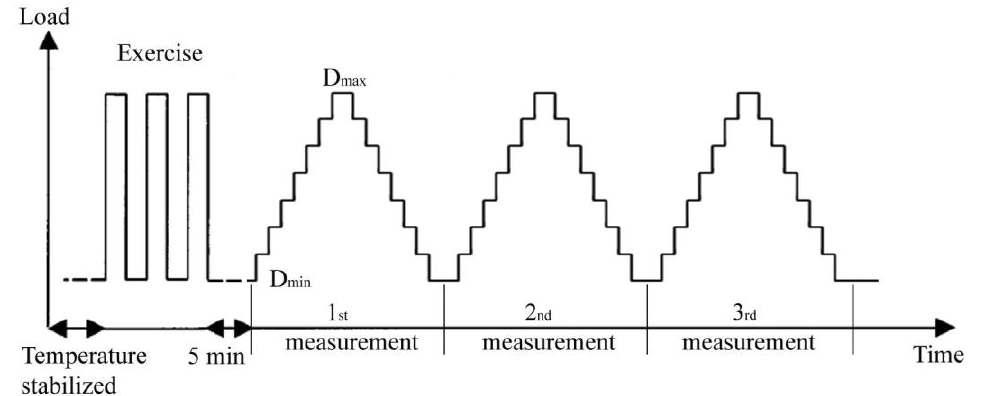
Figure 8. Test sequence for each